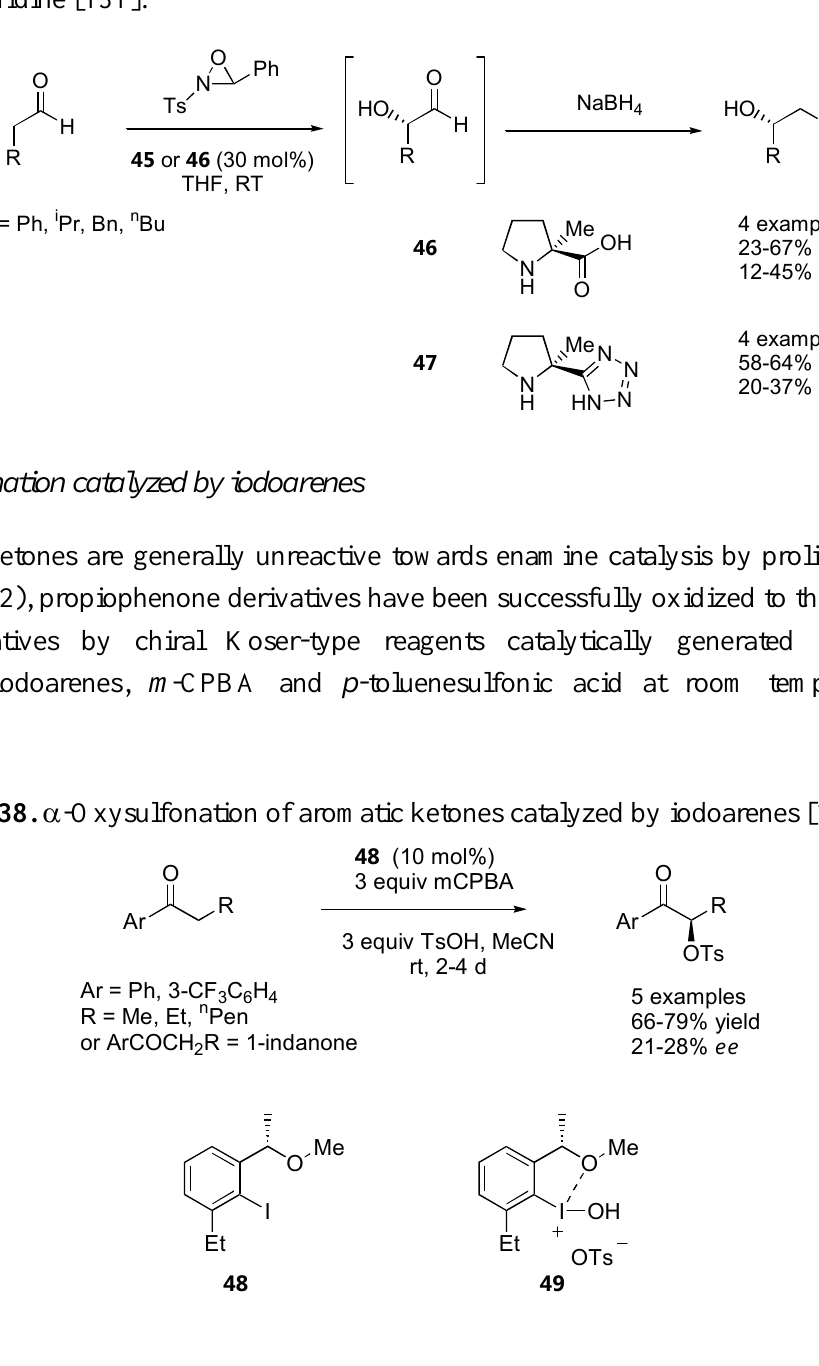
Figure 37.  -Methylproline ( 46 ) and tetrazole ( 47 ) catalyzed  -oxidation of aldehydes with oxaziridine [131].